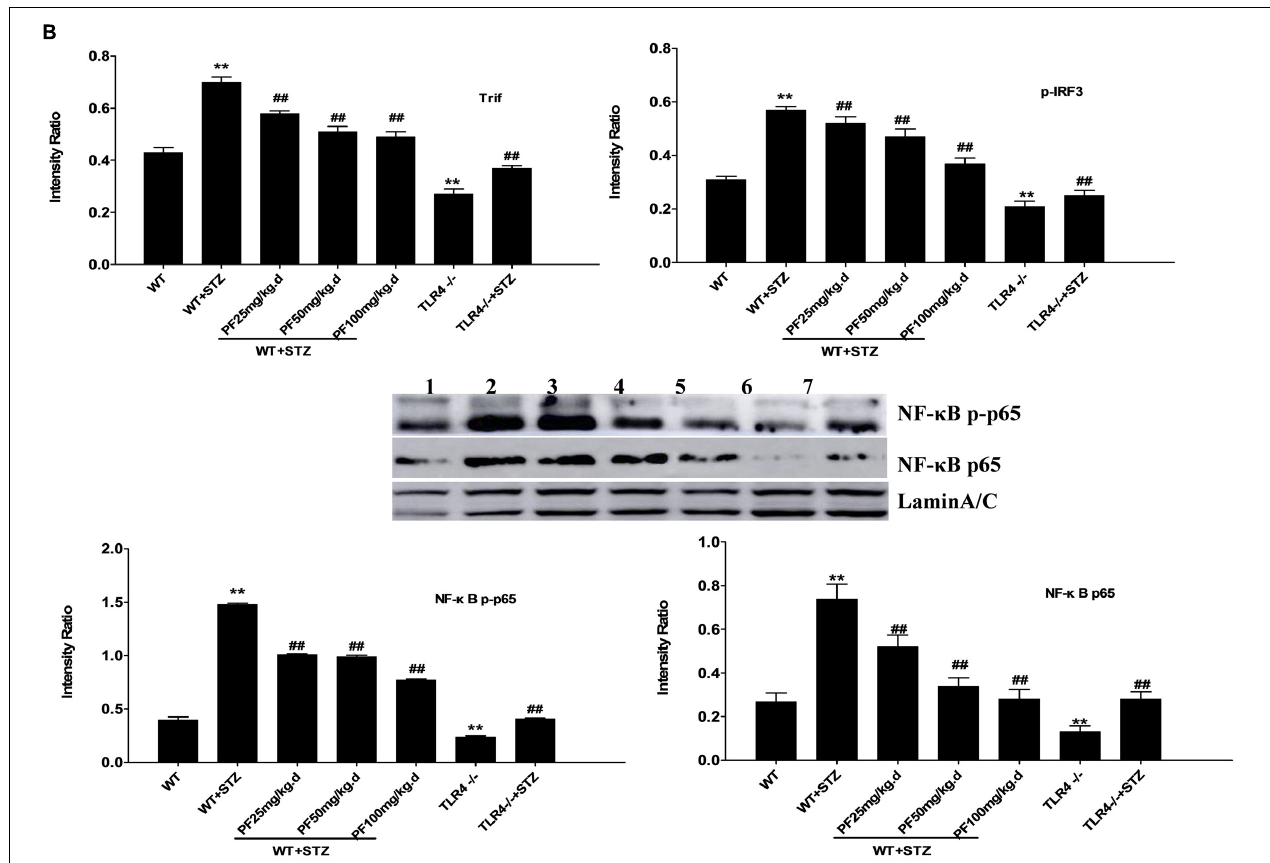
FIGURE 3 | Effects of PF on the expression of TLR4 and downstream signaling pathway molecules in mice from different groups. (A,B) Renal tissue lysates were analyzed by Western blotting to measure the expression of TLR4 and molecules in the downstream signaling pathway, including MyD88, p-IRAK1, Trif, p-IRF3, NF- κ B p-p65, and NF- κ B p65. All data are expressed as the mean ± SD from at least three independent experiments. ∗ p < 0.05 and ∗∗ p < 0.01 vs. WT; # p < 0.05 and ## p < 0.01 vs. WT+STZ; NS, not significant. Lanes: 1, WT; 2, WT+STZ; 3, WT+STZ+PF 25 mg/kg; 4, WT+STZ+PF 50 mg/kg; 5, WT+STZ+PF 100 mg/kg; 6, TLR4-/-; and 7,